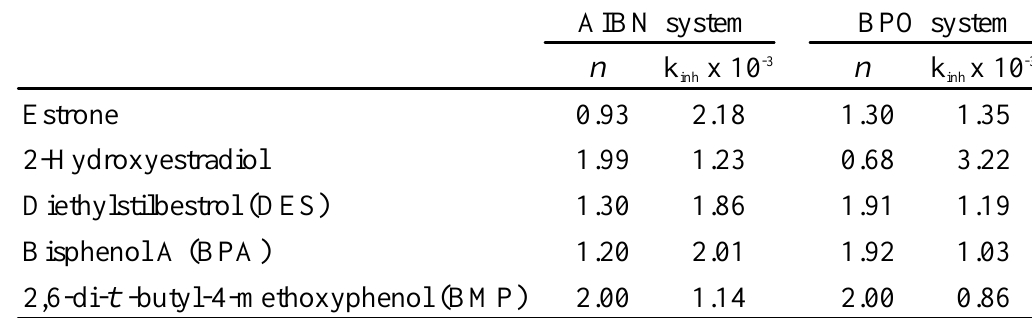
Table 1 . Stoichiometric factors ( n ) and inhibition rate constants (k estrogens and estrogen-like compounds in the AIBN and BPO system